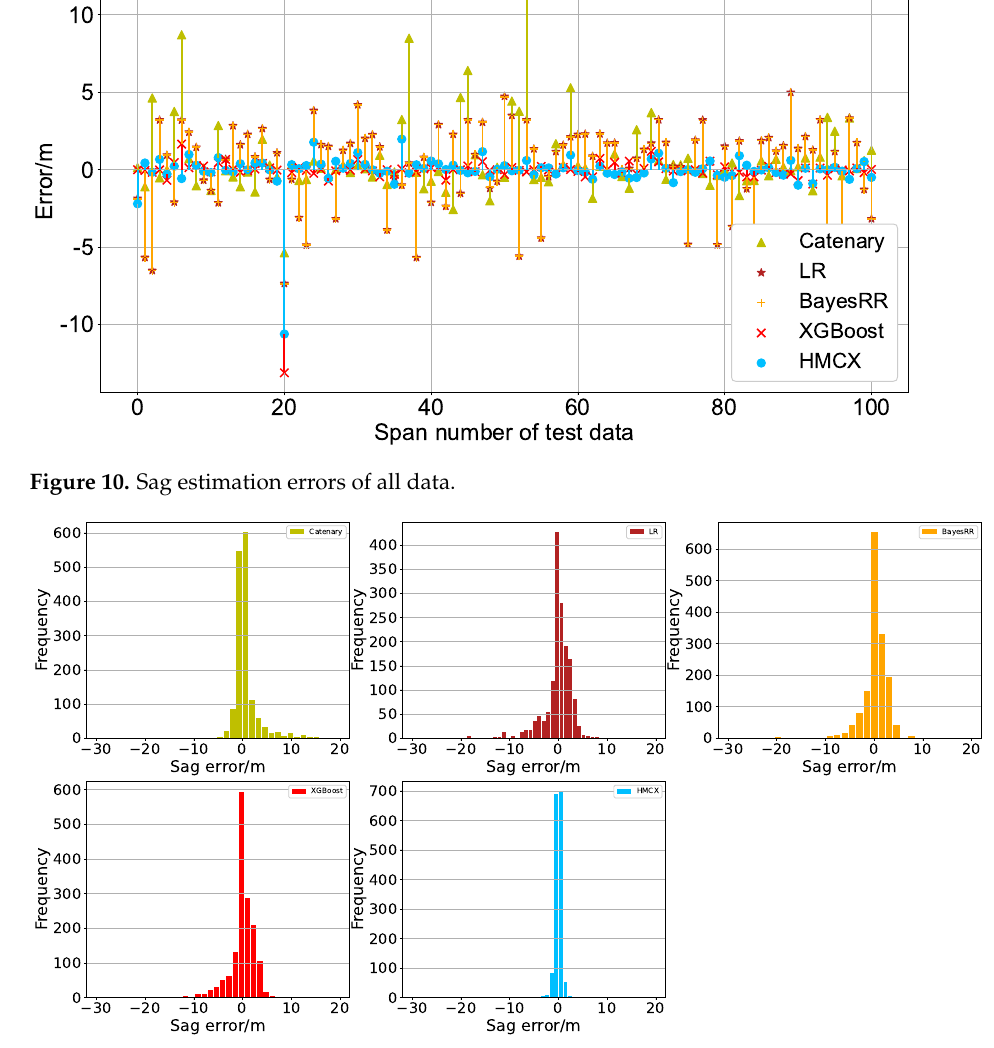
Figure 11. The frequency distributions of sag error for all